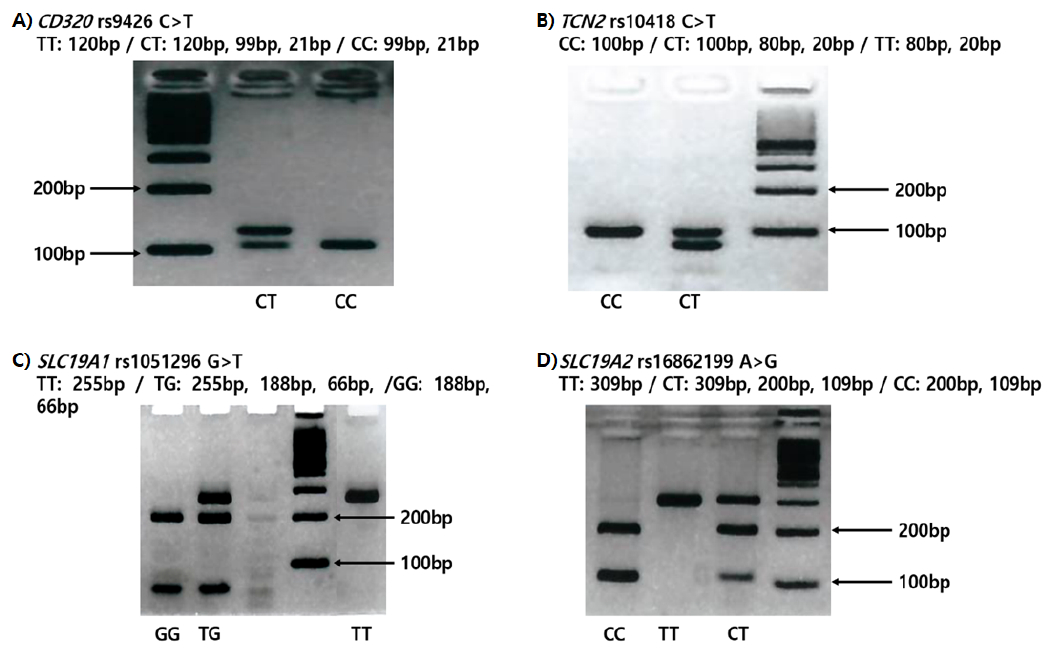
Figure 1. Restriction fragment length polymorphism (RFLP) variations according to genotypes. ( A ) CD320 rs9426 C > T ( B ) TCN2 rs10418 C > T ( C ) SLC19A1 rs1051296 G > T ( D ) SLC19A2 rs16862199 C >